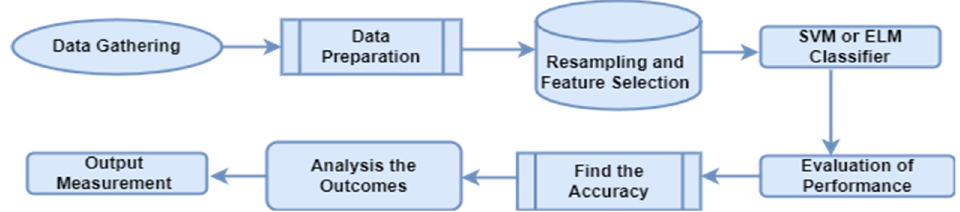
Figure 6. Proposed prediction model after using feature selection with the SVM and ELM classifi ‐ ers .